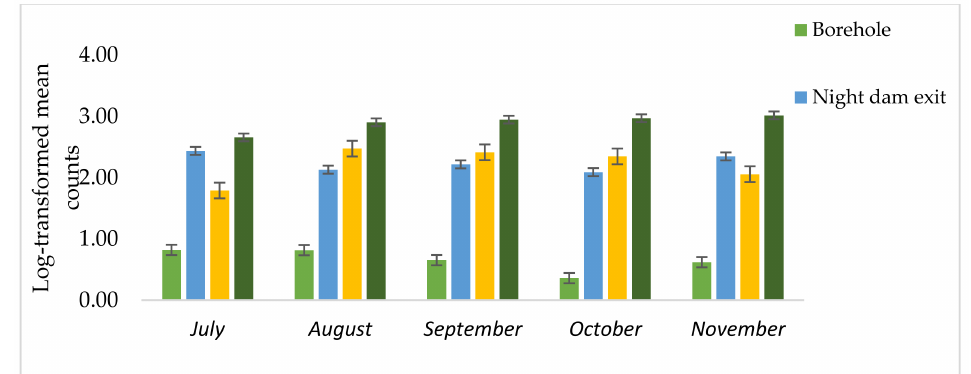
Figure 7. Log transformed salmonella sppcounts as distributed along the wastewater treatment pathway from Pond 16 exit to night-dam exit for five months in